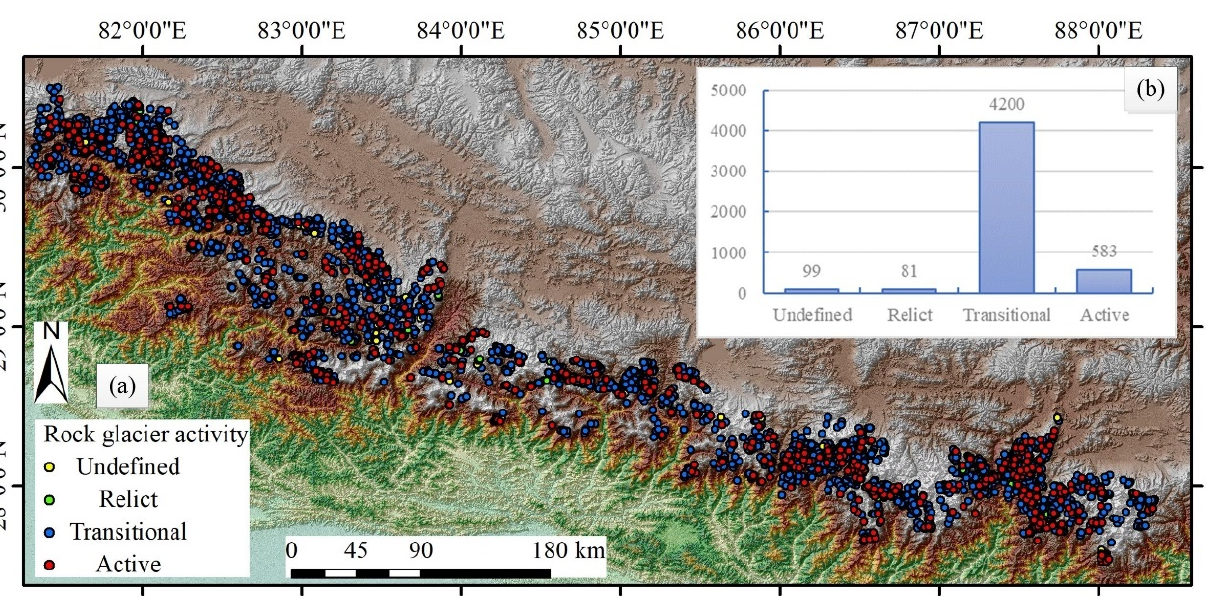
Figure 15. The activity classification follows the IPA Action Group guidelines. ( a ) Overview of the rock glacier activity classification results. ( b ) The distribution statistics of rock glacier activity.